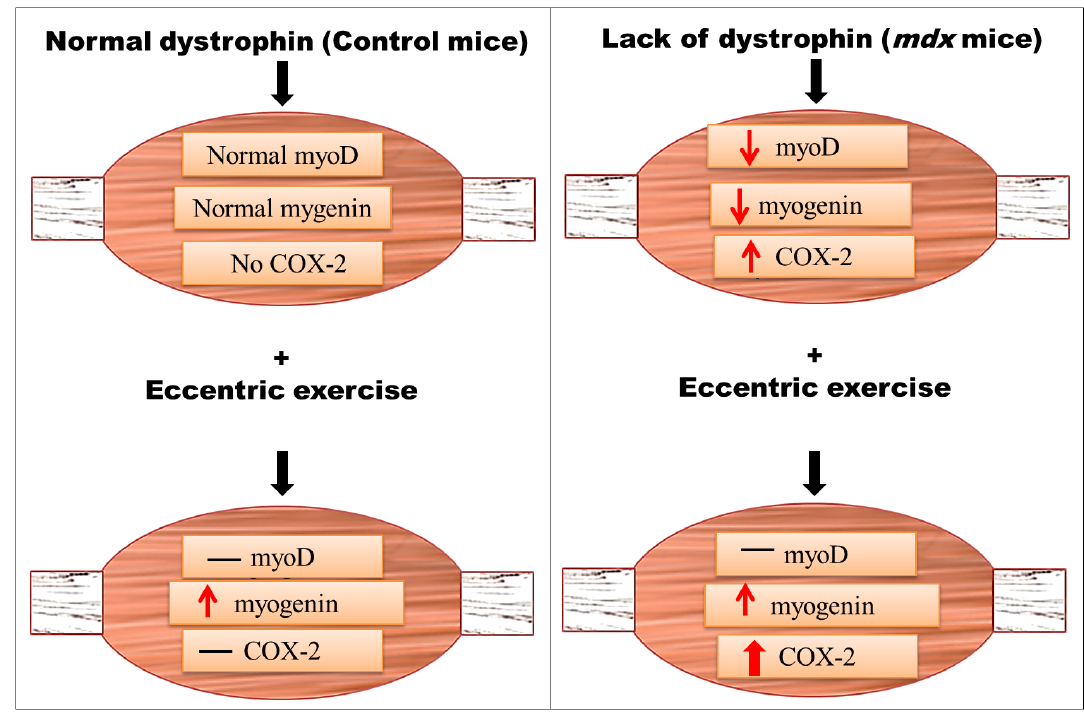
Figure - 7 Schematic response of biomarkers in Control (normal dystrophin) and Mdx (lack of dystrophin) mice after eccentric exercise training. After training, Control mice increase myogenin and do not alters myoD and COX-2 immunoexpressions. Regarding mdx mice, lack of dystrophin provokes decrease of myogenic regulatory factors (myoD and myogenin) and increase of COX-2. After eccentric exercise training, myoD immunoexpression in mdx do not alter but myogenin increase and COX-2 had exacerbated response. Note that the increase of myogenin occurred due to exercise and not aggravated by lack of